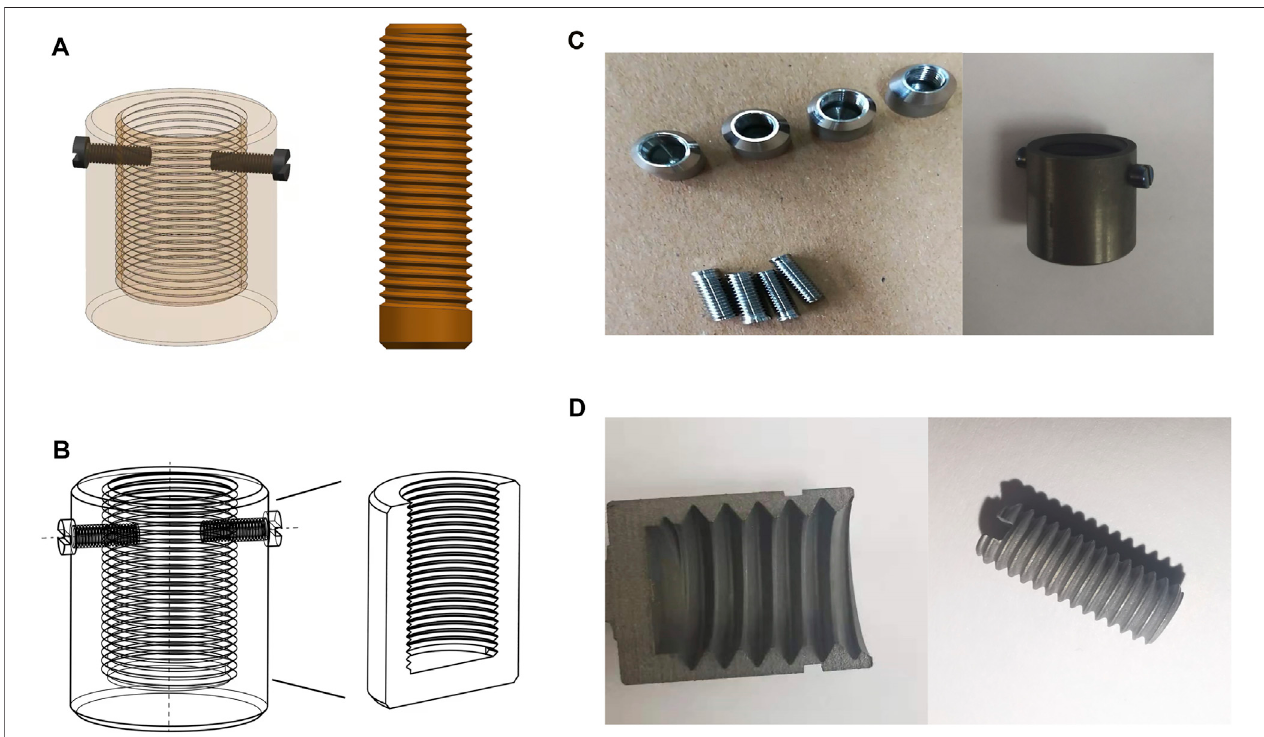
FIGURE 2| Three-dimensional model diagram and mechanical processing ofimplants. (A) 3D mechanical processing diagram of the external cap implant and the internal column implant; (B) the model diagram of the inner morphology of the external cap implant; (C) samples of mechanically processed external cap implant and internal columnar implant; (D) implant appearance with surface treatment by sandblasting acid etching.